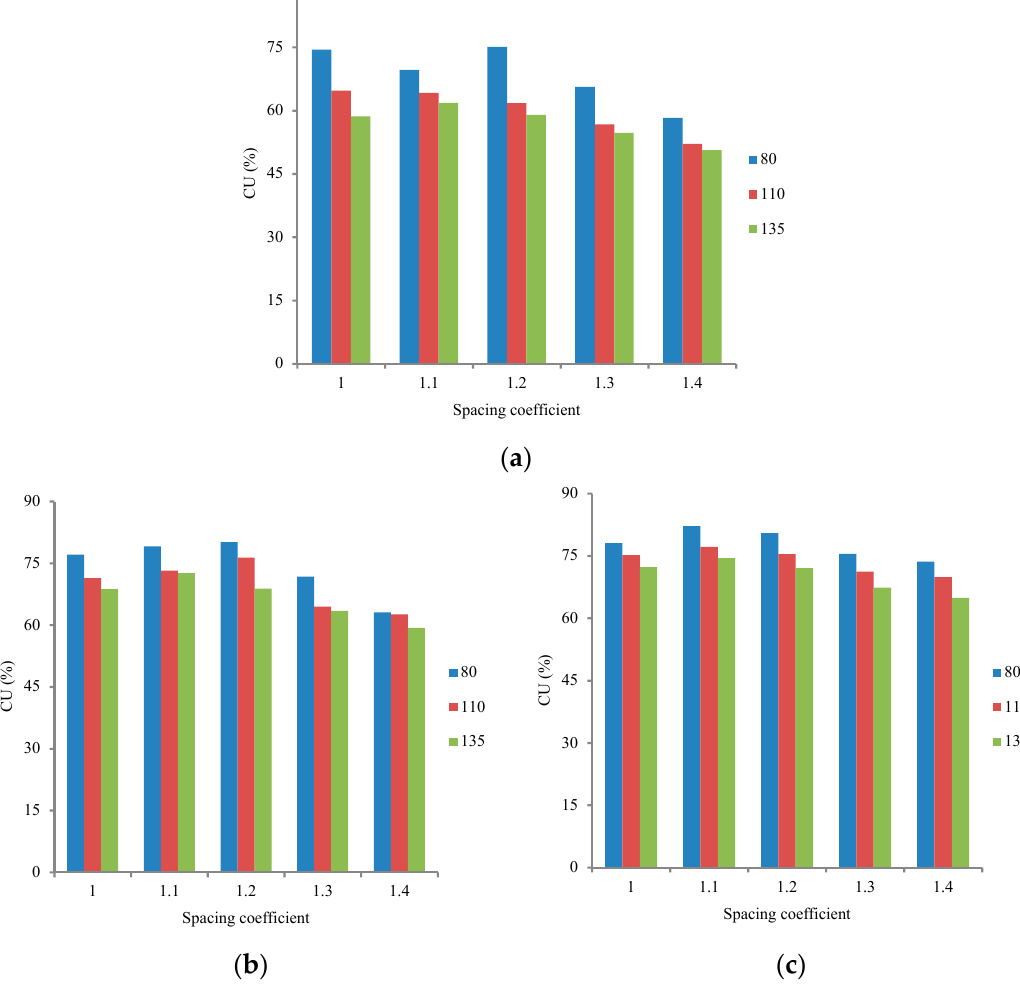
Figure 8. Relationships between CU values and spacing coefficients with different counterweight- installed positions. ( a ) working pressure of 0.30 MPa, ( b ) working pressure of 0.35 MPa, ( c ) working pressure of 0.40 MPa.